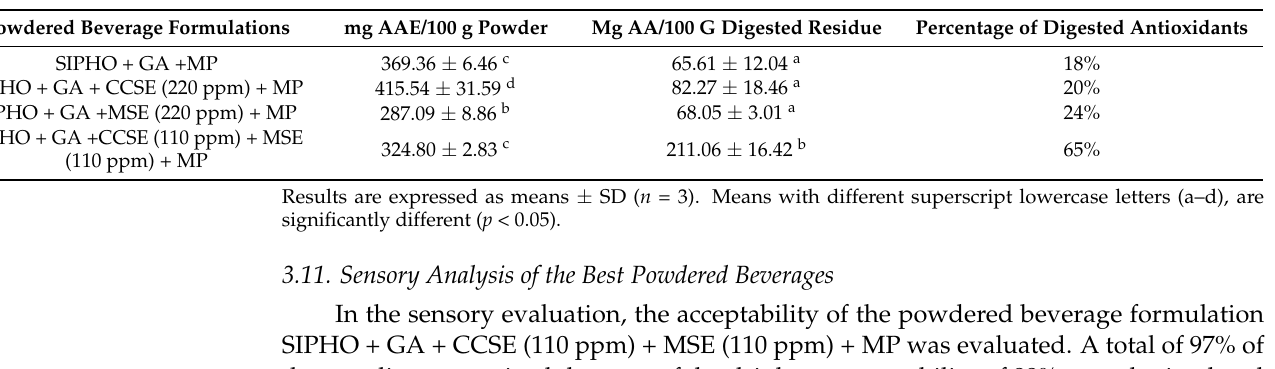
Table 9. Antioxidant activity (mg AAE/100 g powder) and bioaccessibility (%) of powdered bever- age